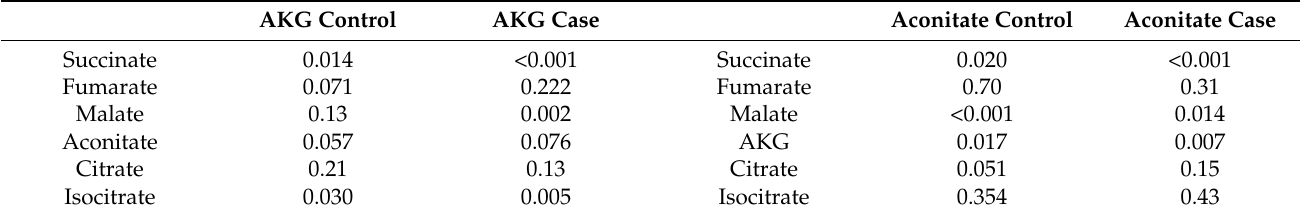
Table 4. AKG and aconitate Relationships to other CAC intermediates ( p -values).